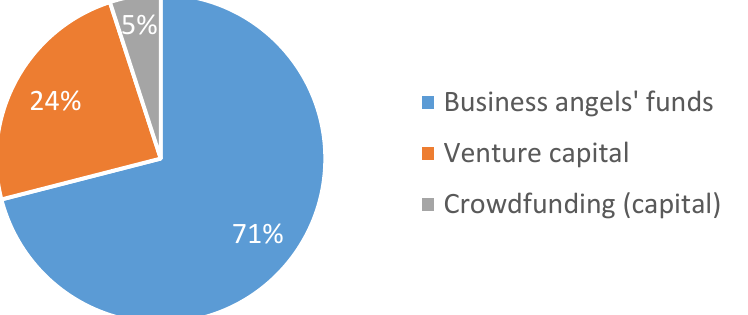
Figure 3. Investment in the early stage of EU SBE life cycle, bln. of Euro/% in